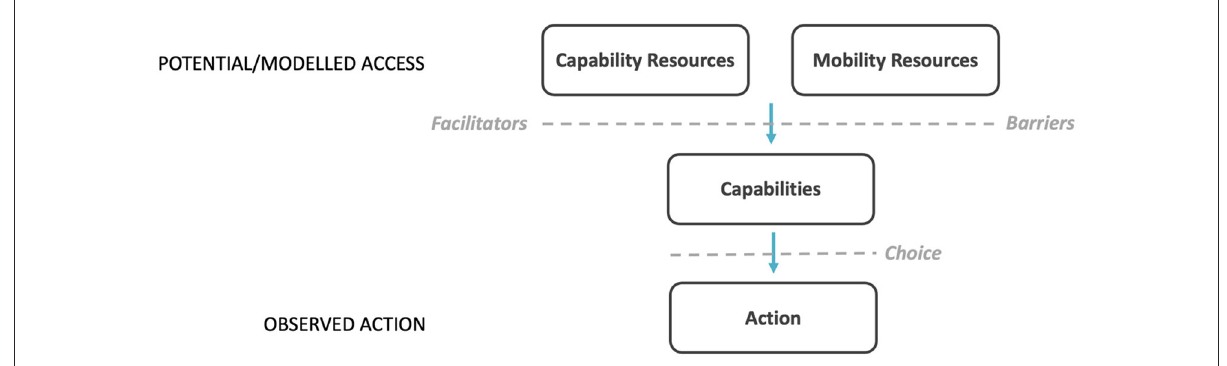
FIGURE3 A capabilities approach to conceptualizing travel